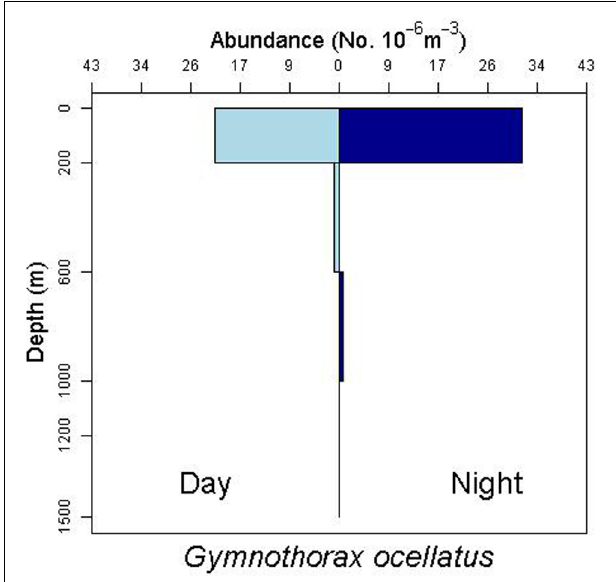
FIGURE 7 | Depth profile for the nettastomatid leptocephalus Hoplunnis tenuis , suggesting diel vertical migration with moderate numbers of individuals below 200 m during the